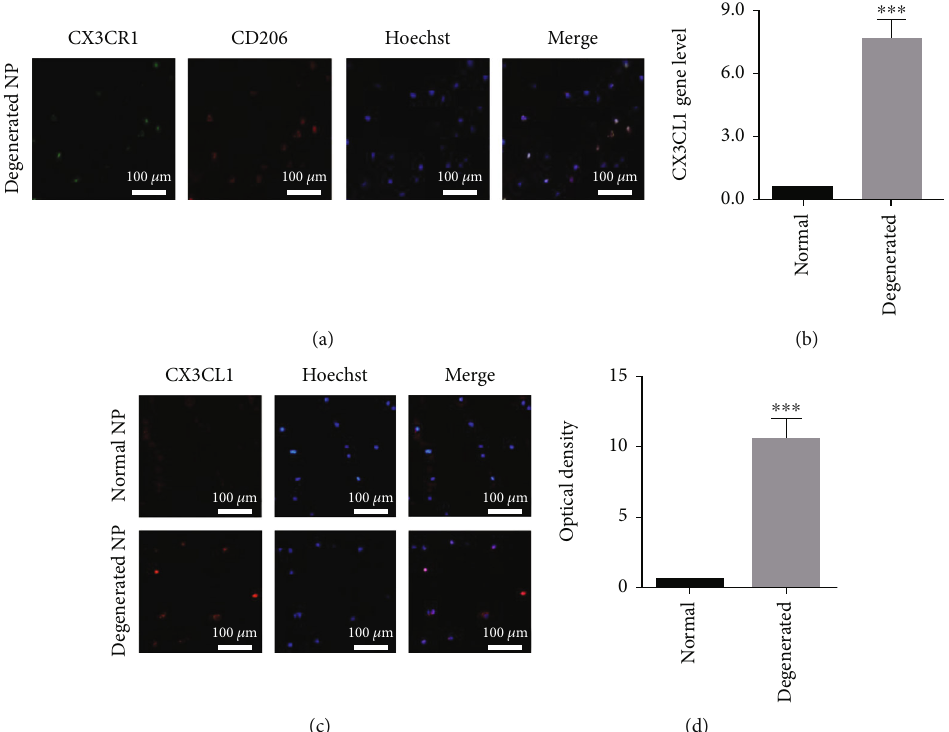
Figure 5: Almost all CD206+M2 macrophages expressed high level of CX3CR1 (a). RT-PCR (b) and immuno fl uorescent staining (c, d) con fi rmed that degenerated NP tissue expressed signi fi cantly higher level of CX3CL1. “ ∗∗∗ ” indicates p < 0 : 001 . IVD: intervertebral disc. NP; nucleus pulposus.